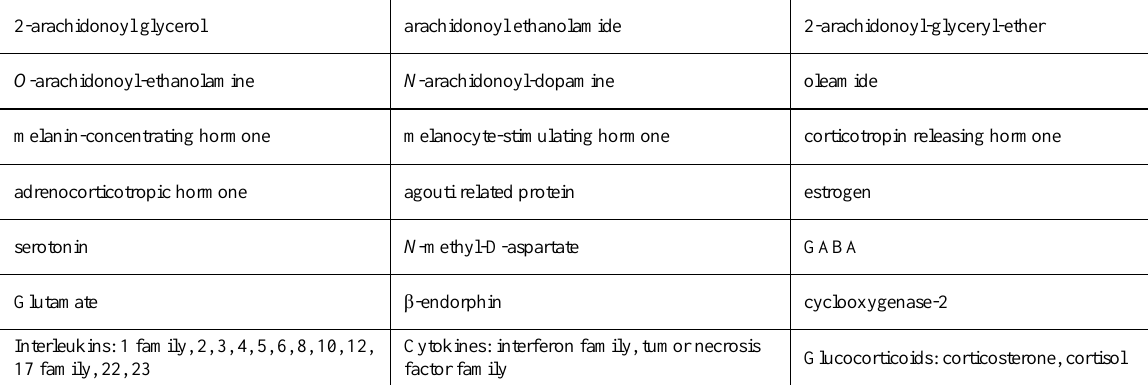
Table 1. Proteins of interest in ASD pathology